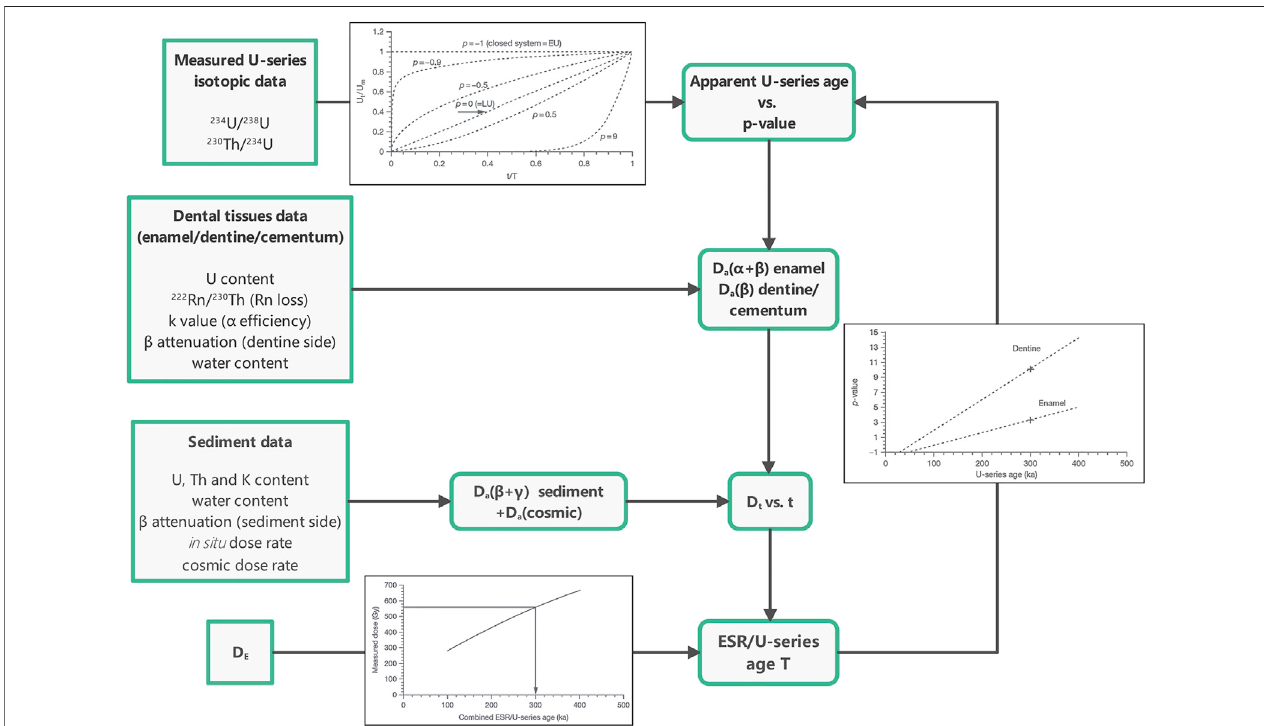
FIGURE 1 | Flowchart of the ESR/U-series age calculation process with the US model ( p -value) (after Grün et al., 1988).